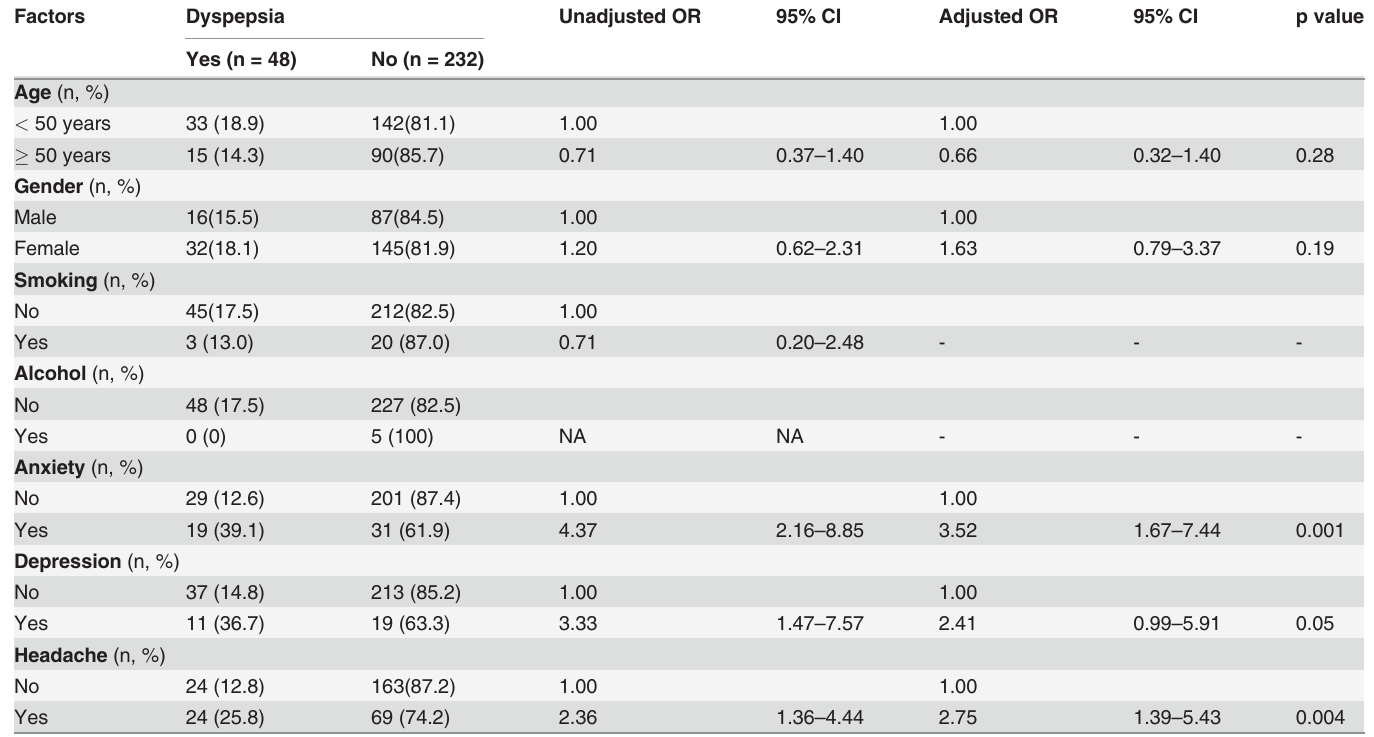
Table 3. Multivariate analysis of predictors of